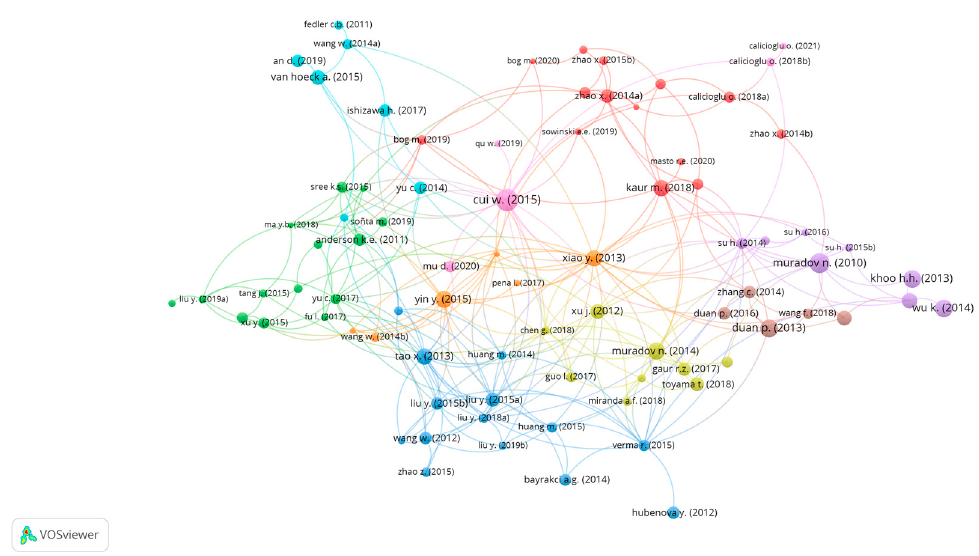
Figure 9. Co-citations of the documents. Table 4. Sources with high impacts based on normalized